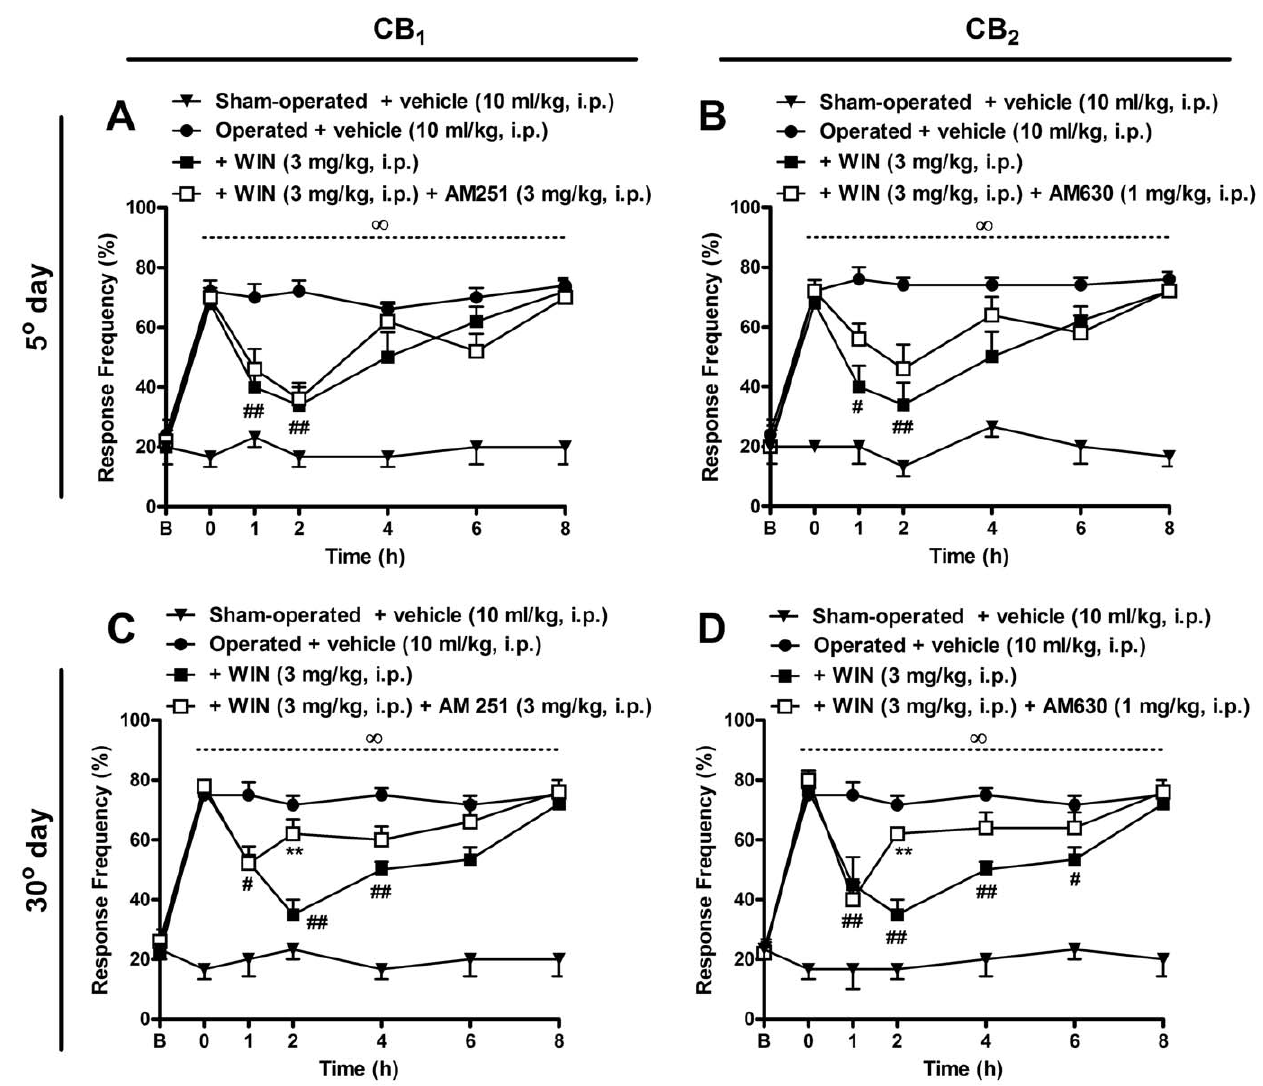
Figure 8. Effects of pre-treatment with selective cannabinoid antagonists, administered on the 5 th and 30 th days after brachial plexus avulsion (BPA), on analgesia produced by WIN 55,212-2 treatment in mice. Response frequency of the right hindpaw assessed at several time-points in operated (BPA) mice treated with vehicle (10 ml/kg, i.p.) or a CB 1 -selective antagonist (AM 251, 3 mg/kg, i.p.) (A and C) or a CB 2 - selective antagonist (AM 630, 1 mg/kg, i.p.) (B and D) 30 min before systemic treatment with the non-selective agonist, WIN 55,212-2 (3 mg/kg, i.p.) administered on the 5 th (A and B) or 30 th (C and D) day after surgery. Data are expressed as mean 6 SEM (n=4–6/group). # p , 0.01, significantly different from the operate-vehicle-treated group. **p , 0.01, significantly different from the WIN 55,212-2 treated group, and ‘ p , 0,01 is significantly different from sham-operated treated with vehicle (two-way ANOVA with Bonferroni’s post hoc test).